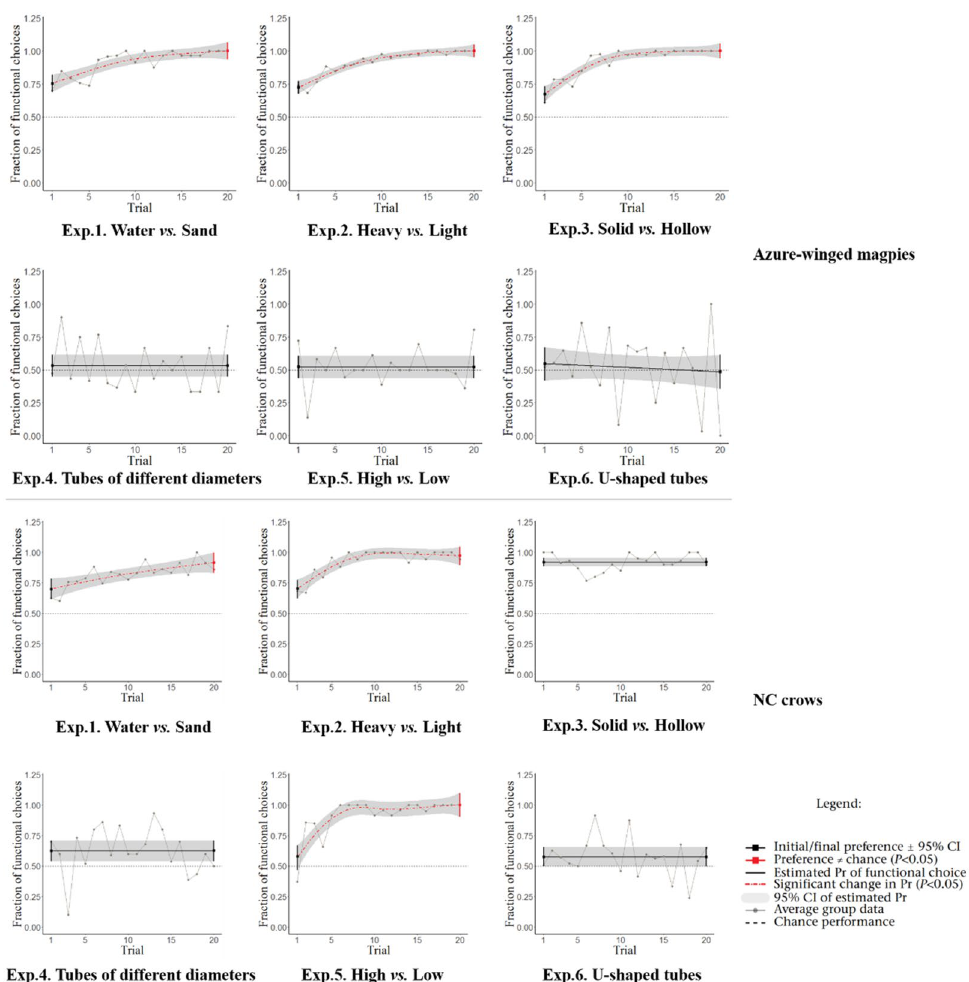
Figure 5. Experimental results of Azure-winged magpies and New Caledonian (NC) crows. Dotted lines represent the probability that the functional option will be selected. Gray dots denote the proportion of functional options selected by all subjects in each trial. Solid lines indicate the probability of a functional choice as estimated by GAM regression (see Methods). Lines are depicted in red and dots are shown as dashes when the probability significantly increases; otherwise, the lines are shown as black only. The first and last probability estimates are represented by solid dots. The dots are marked as red if there is a significant difference between the first and last probability estimates and the dotted line value ( P < 0.05); otherwise, the dots are shown as black. The gray area represents the 95% confidence interval of the probability estimate represented by the implementation.